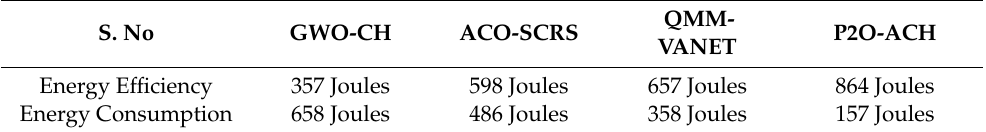
Figure 3. Energy Consumption Calculation. Table 5. Performance Values of Energy Efficiency and Energy Consumption of the